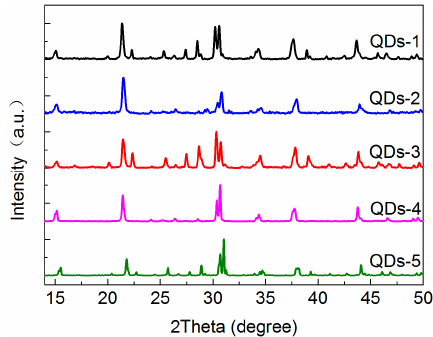
Figure A1. XRD patterns of QDs-1~QDs-5. Materials 2018 , 11 , x FOR PEER REVIEW